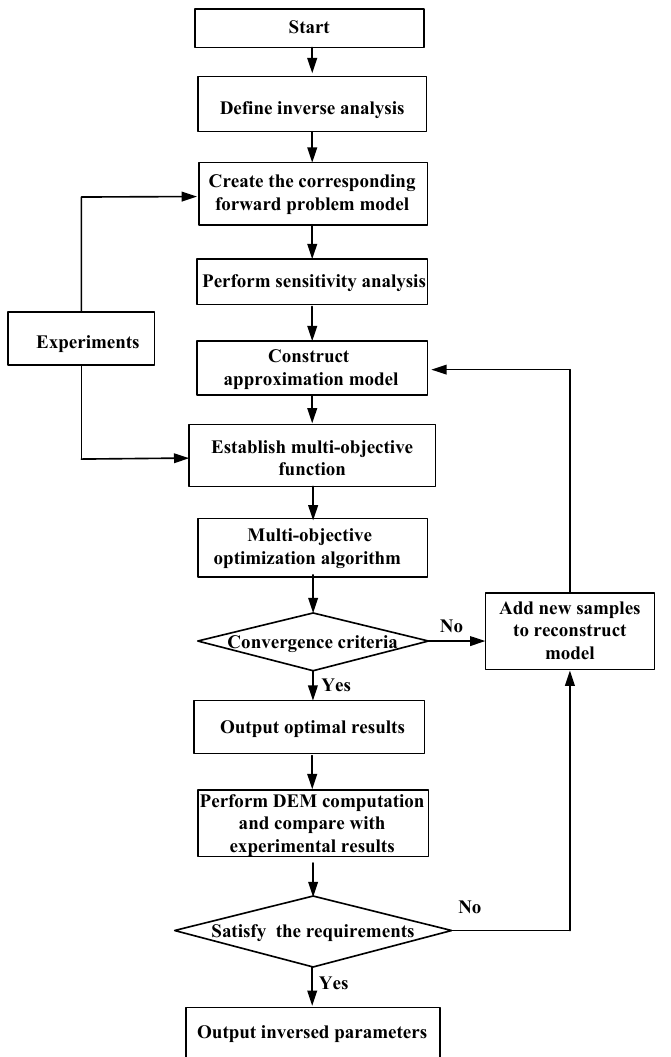
Figure 1. Flowchart of multi-objective identification technique.